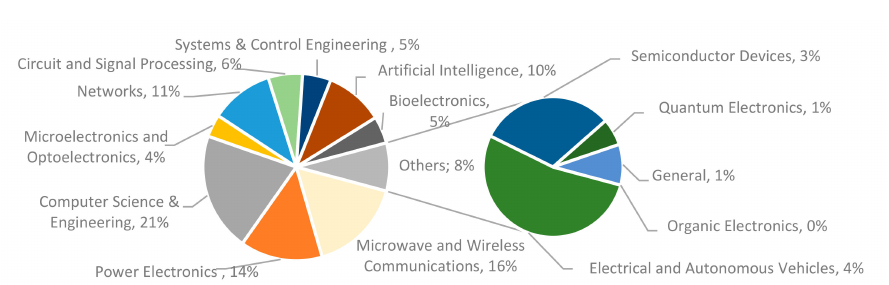
Figure 4. Distribution of manuscripts by section.